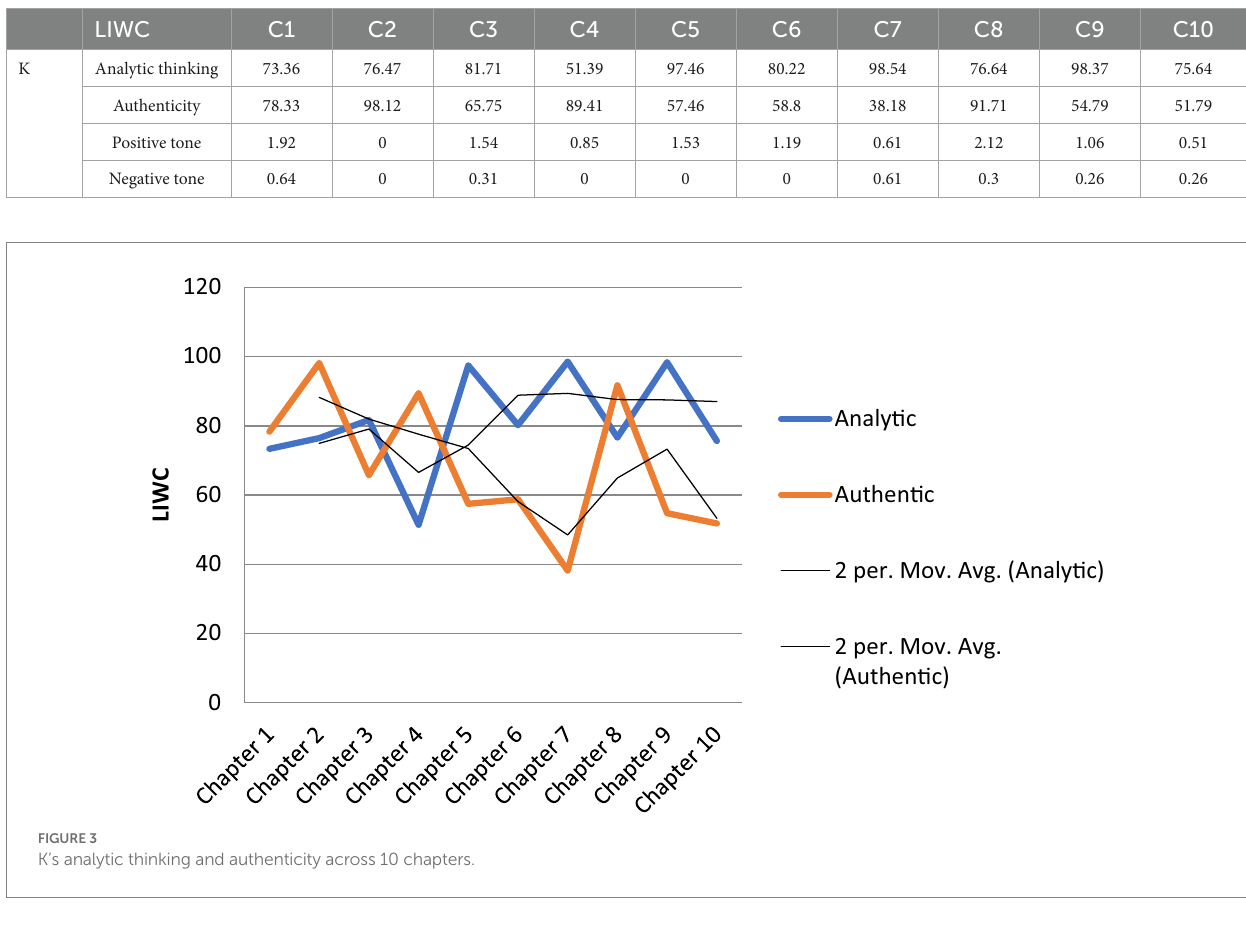
TABLE 4 K’s LIWC scores across 10 chapters.